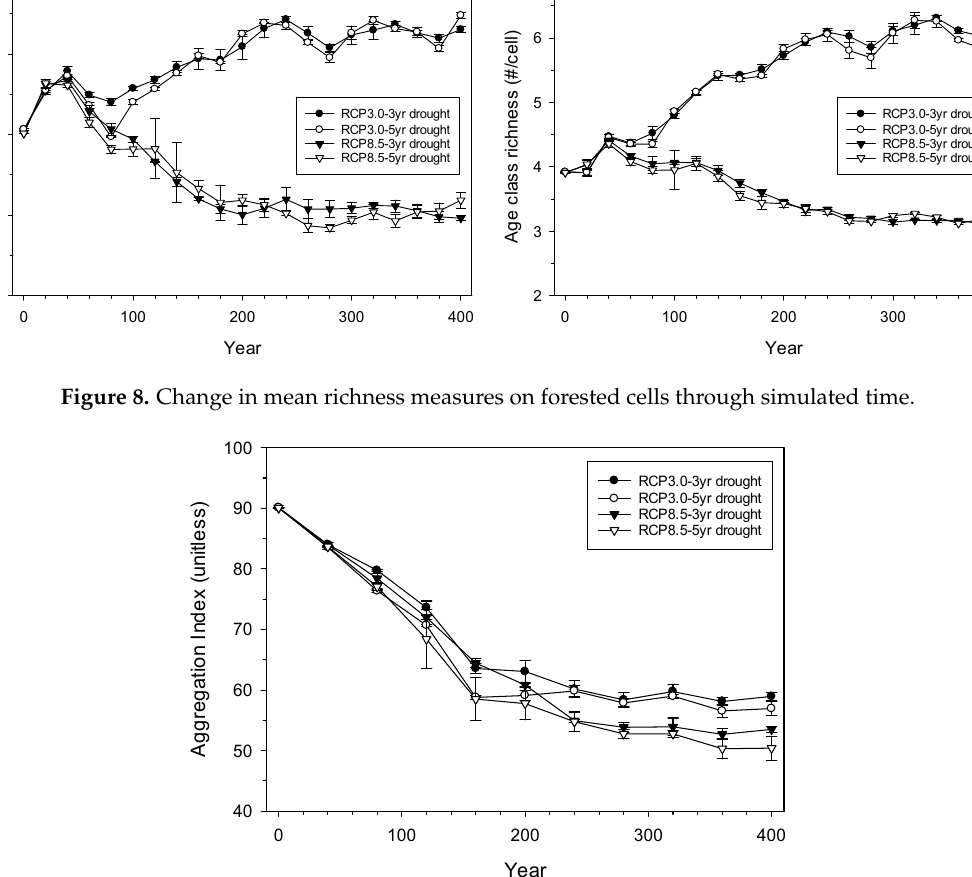
Figure 9. Change in Aggregation Index (measure of clumpiness) through simulated time on maps classified by forest type.